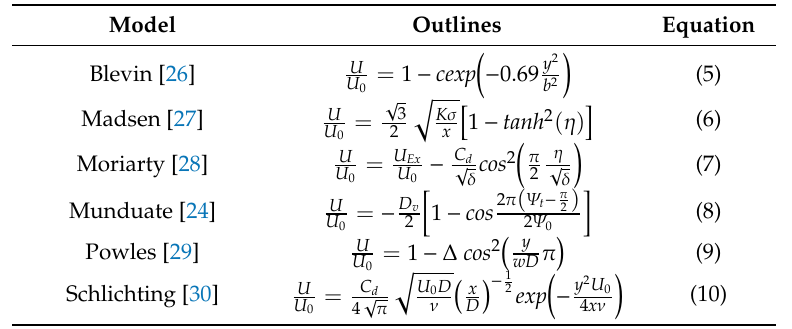
Table 1. Tower wake